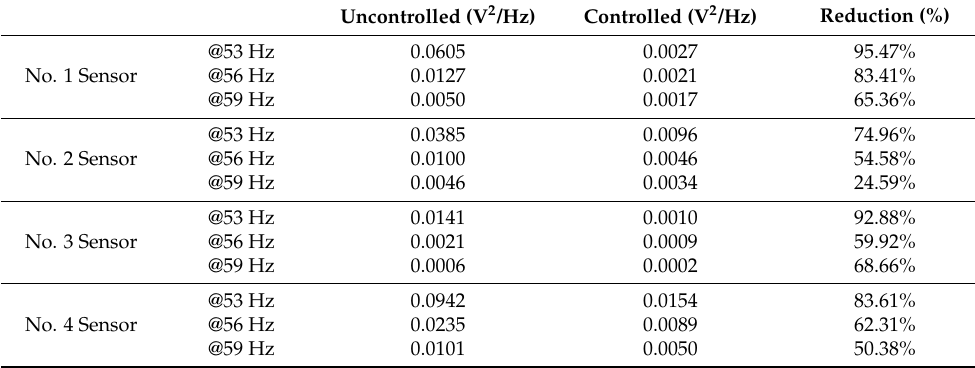
Figure 16. Sensor signals obtained by experiments (1 mV represents 0.1 m/s 2 ). Table 6. Peak values of PSD curves of sensor signals: Experiment